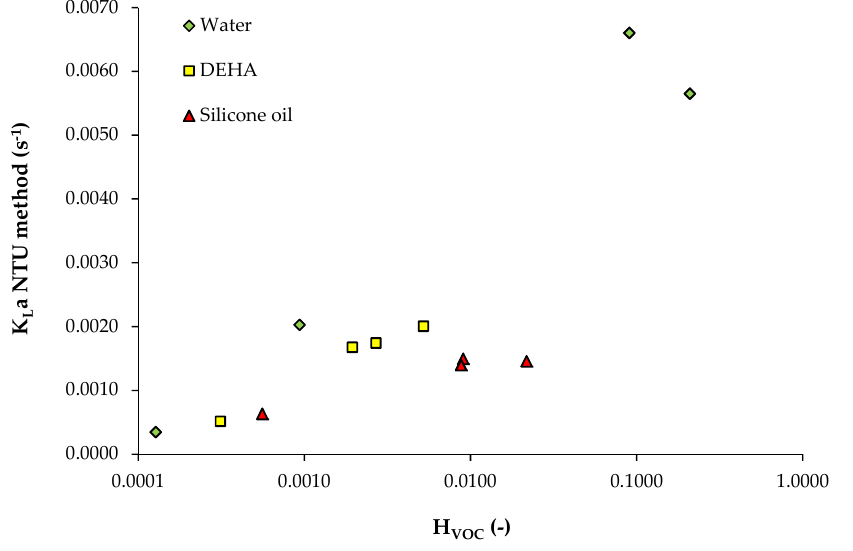
Figure 5. K L a versus the Henry coefficient (H VOC ) from the data analysis reported in Biard et al. [1]. For all the simulations: gas flow-rate = 1.20 m 3 /s (gas EBRT = 2 s); liquid flow-rate = 3.06 × 10 −3 m 3 /s; and V = 2.36 m 3 (T = 20 °C). Table 3. K L a determination using the data reported in Biard et al. [1]. For all the simulations: gas flow- rate = 1.20 m 3 /s (gas EBRT = 2 s); liquid flow-rate = 3.06 × 10 −3 m 3 /s; and V = 2.36 m 3 (T = 20 °C).